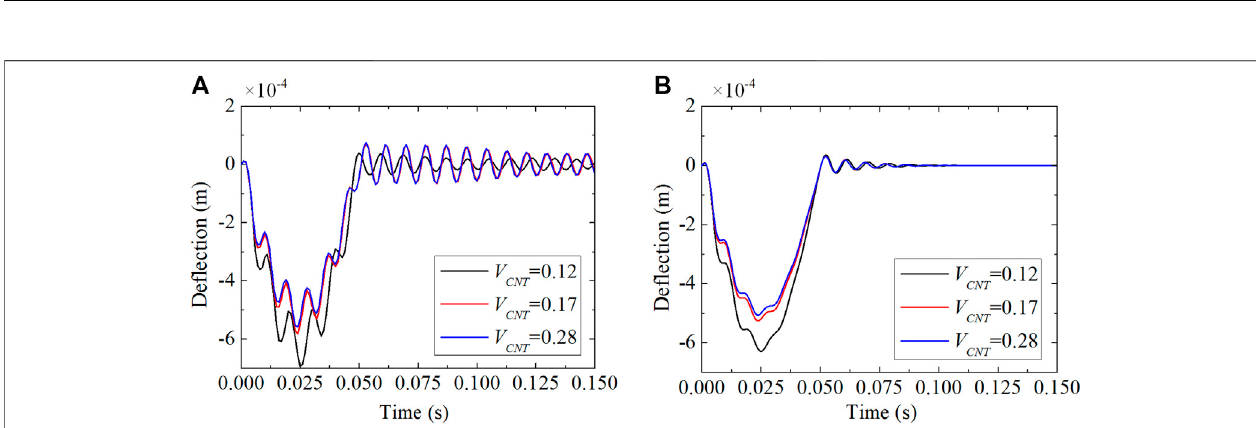
FIGURE7 | Central de fl ection response control under CFCF boundary conditions subjected tostep load with different velocityfeedback gains: (A) G v = 0.001; (B) G v = 0.01.